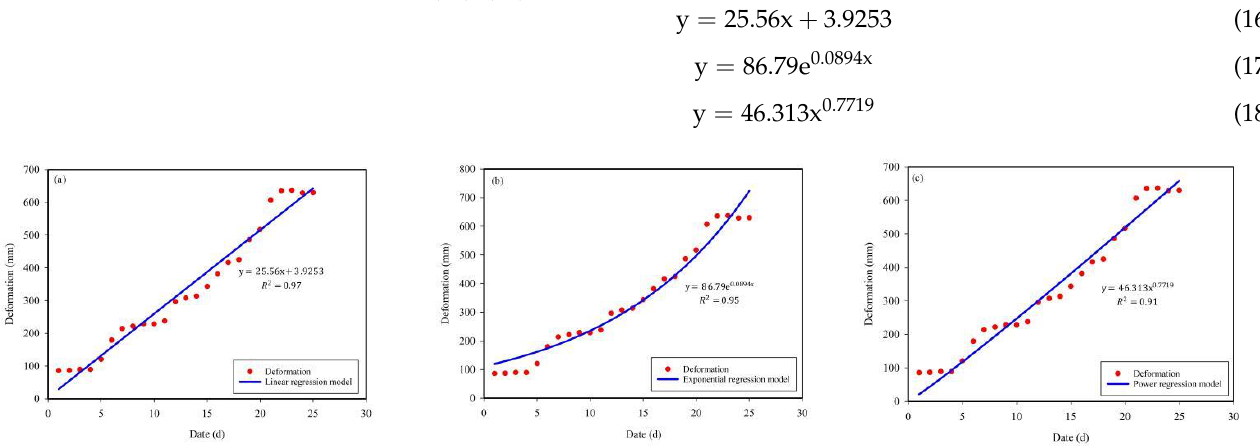
Figure 5. The results of regression analysis in the second threshold interval with different regression models. ( a ) Linear regression model; ( b ) exponential regression model; ( c ) power regression model. Figure 6. The results of regression analysis in the third threshold interval with different regression models. ( a ) Linear regression model; ( b ) exponential regression model; ( c ) power regression model.